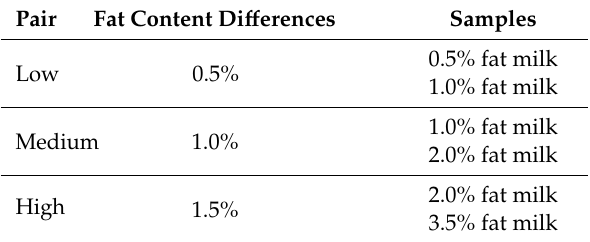
Table 2. Milk samples for the fat sensitivity